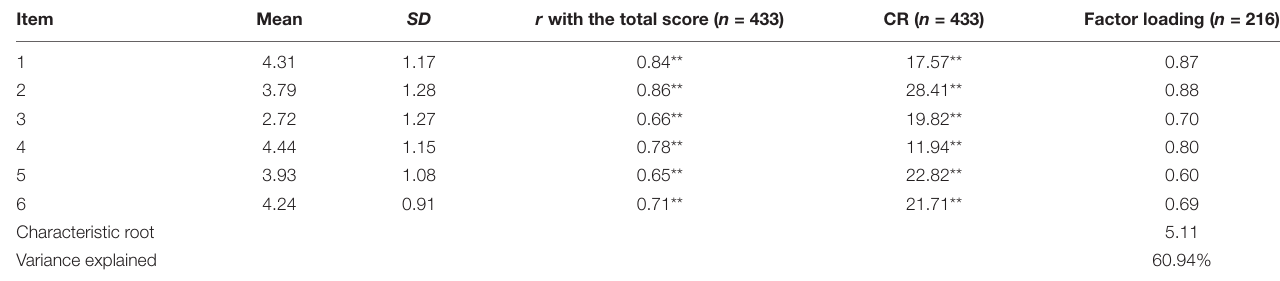
TABLE 1 | Correlation coefficients, critical ratio values and factor loading of items in exploratory factor analysis.